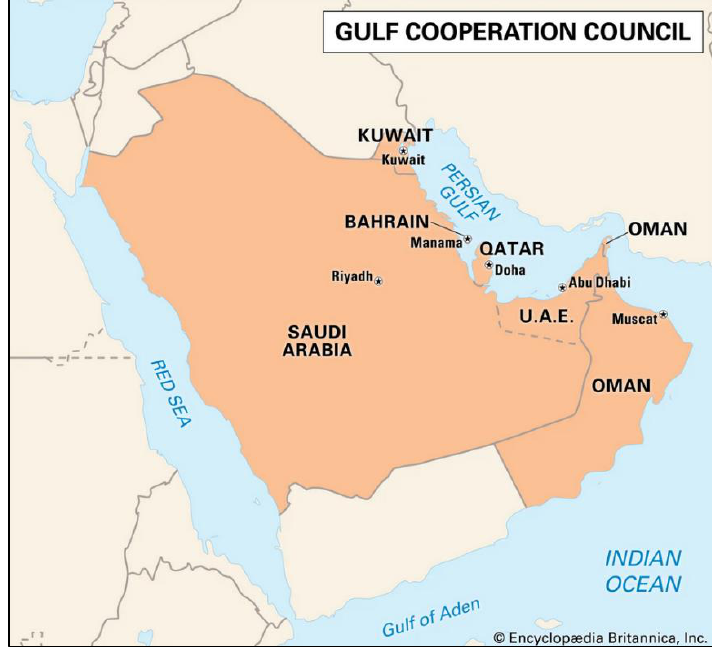
Figure 1. GCC Countries’ Map, and Location